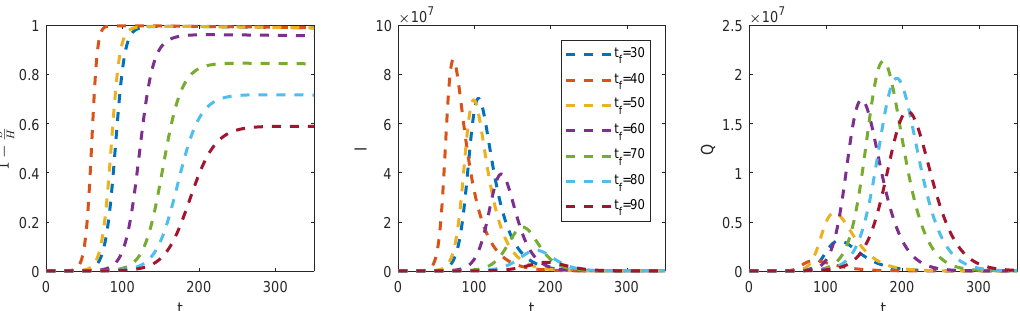
Figure 6. The figure on the left represents the fraction of cumulative infected people, whereas, the figures on the middle and right, respectively, represent the total number of unidentified infected cases and officially confirmed infected cases corresponding to parameters estimated from different length of data.